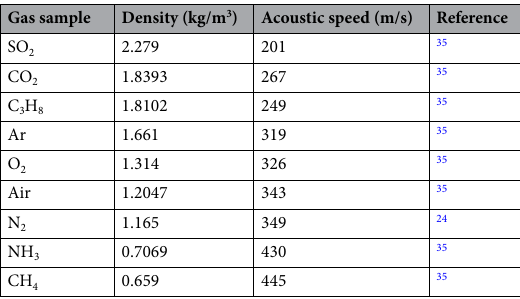
Table 1. Acoustic properties of different gas samples: